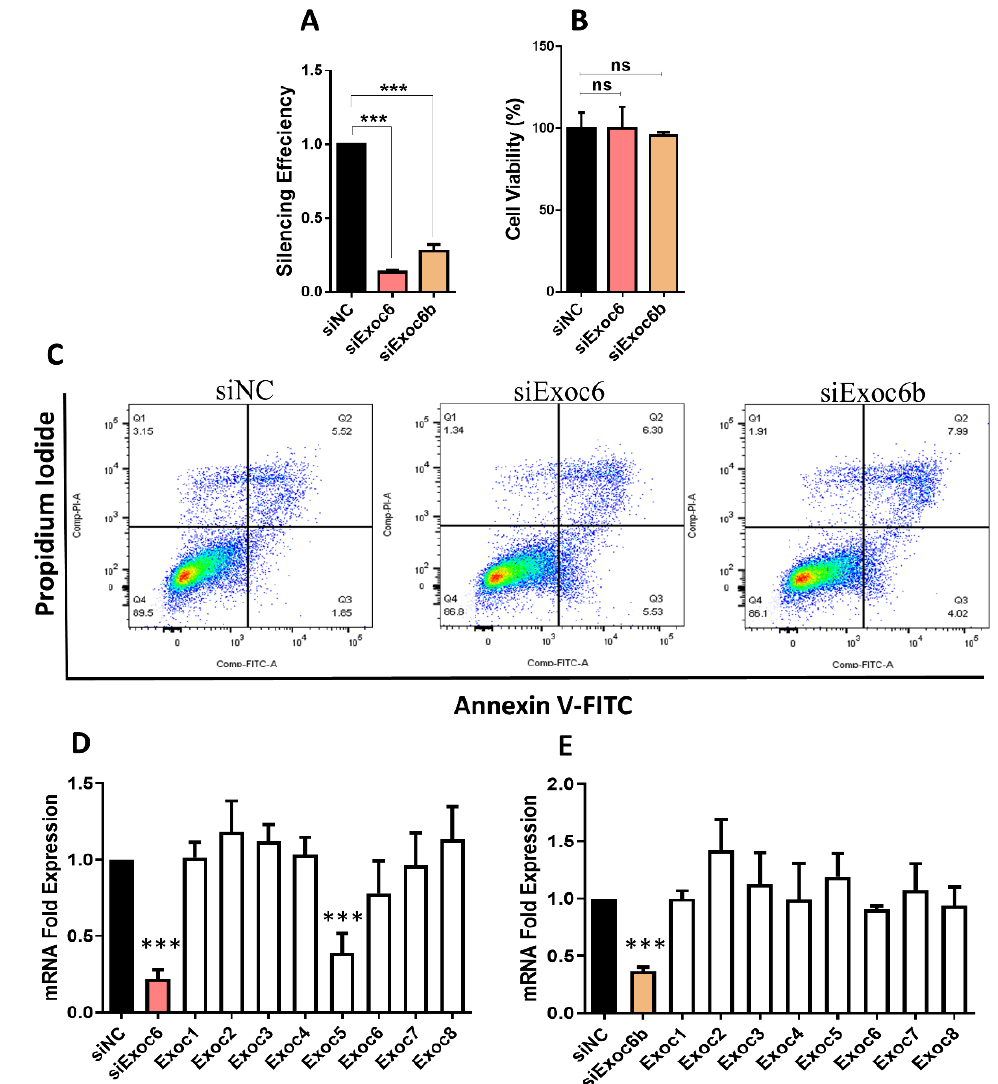
Figure 2. Silencing of Exoc6/6b in INS-1 cells. ( A ) Expression analysis of Exoc6 and Exoc6b as determined by qPCR expression 48 h post-transfection. ( B ) Percentage of cell viability evaluated by MTT assay in Exoc6/6b-silenced cells and control cells. ( C ) Apoptosis level in Exoc6/6b-silenced INS-1 cells compared to negative control cells determined by flow cytometry analysis. ( D – E ) qPCR expression analysis of exocyst subunits in Exoc6 ( D ) or Exoc6b-silenced cells ( E ). ***; p < 0.001. n.s.; not significant. Bars represent mean ± SD. Data were acquired from 3 different experiments.